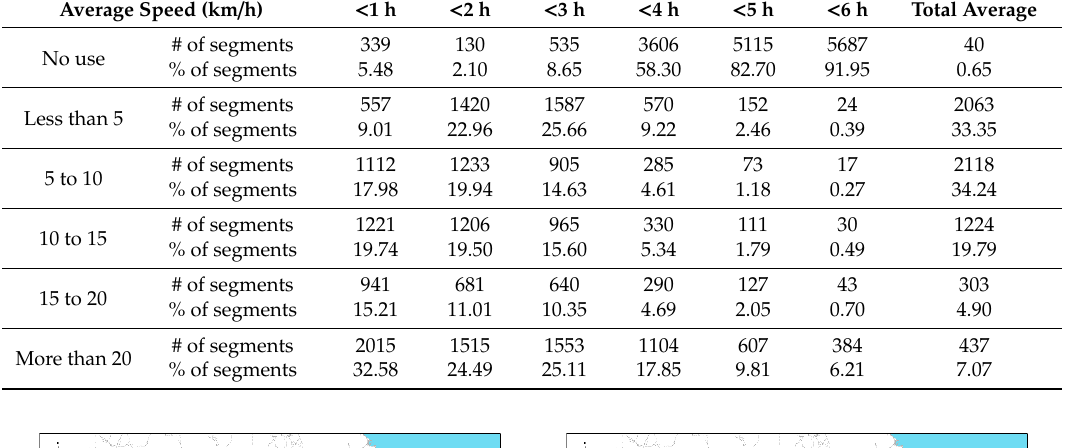
Table 4. Average speed of vehicles from 1 to 6 h after the occurrence of accidents.